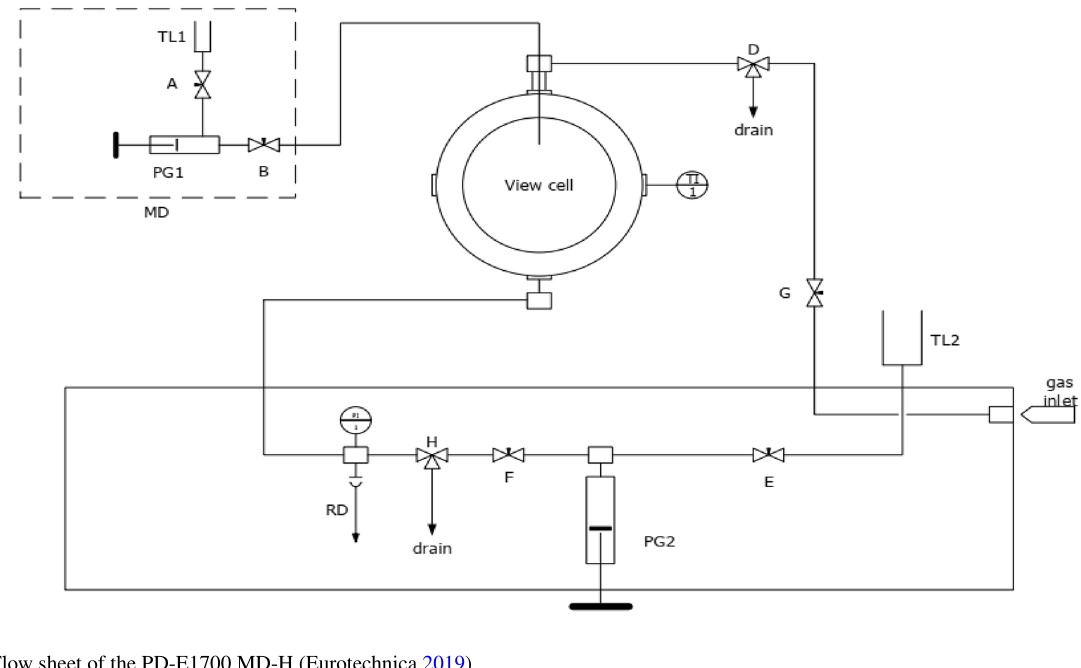
Fig. 1 Flow sheet of the PD-E1700 MD-H (Eurotechnica 2019)